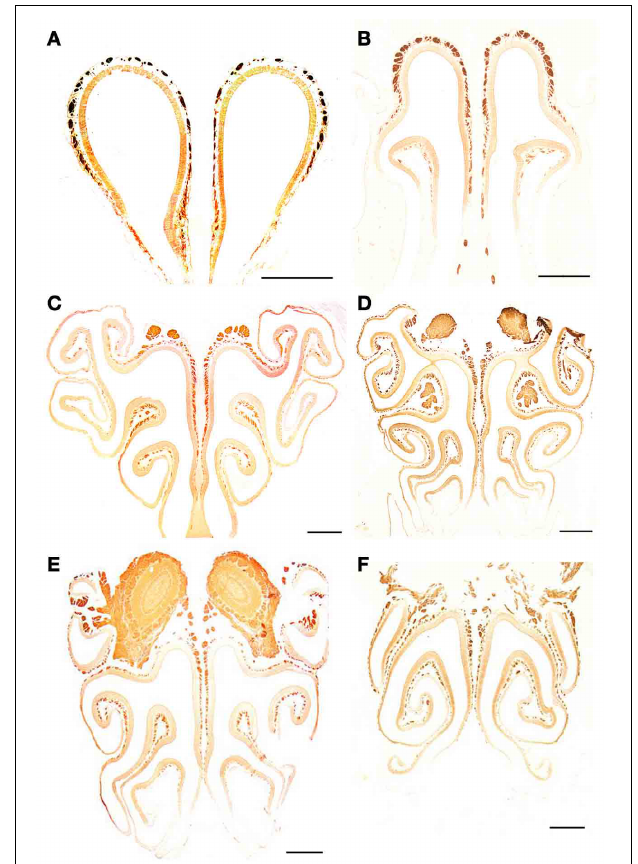
FIGURE 9 | Anti-G α 0 -stained transverse sections of the nasal cavity at the same levels (A–F) as in Figure 8. Note the different reactivities of epithelium and axon bundles. Scale bars: 500 μ